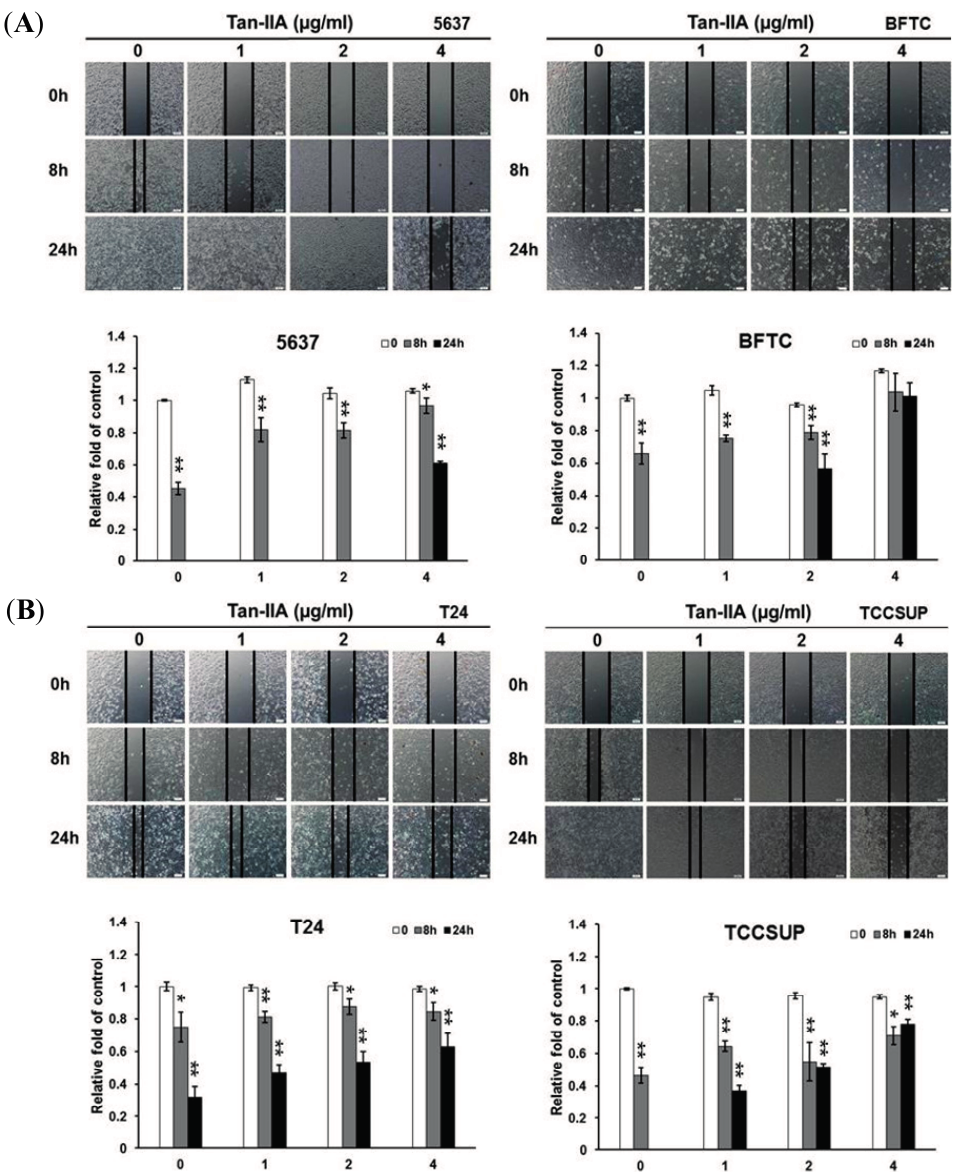
Figure 4. Effect of Tan-IIA on the migration of human bladder cancer cells-wound healing experiment. ( A ) Human bladder cancer cells (5637, BFTC) were treated with 0.2% DMSO as the control or 1 to 4 μ g/mL Tan-IIA for the indicated time points; Scale bar: 100 μ m; ( B ) Human bladder cancer cells (T24, TCCSUP) were treated with 0.2% DMSO as the control or 1 to 4 μ g/mL Tan-IIA for the indicated time points. Images of wound closures were captured using inverted microscope with 100× magnification; Scale bar: 100 μ m. The cell-free area invaded by migrated cells across the black lines were calculated by three randomized fields and quantified. The cell-free distance at 0 h were set at as 100%. Data are from three different experiments and presented as means ± S.D. * p < 0.05; ** p < 0.01 versus